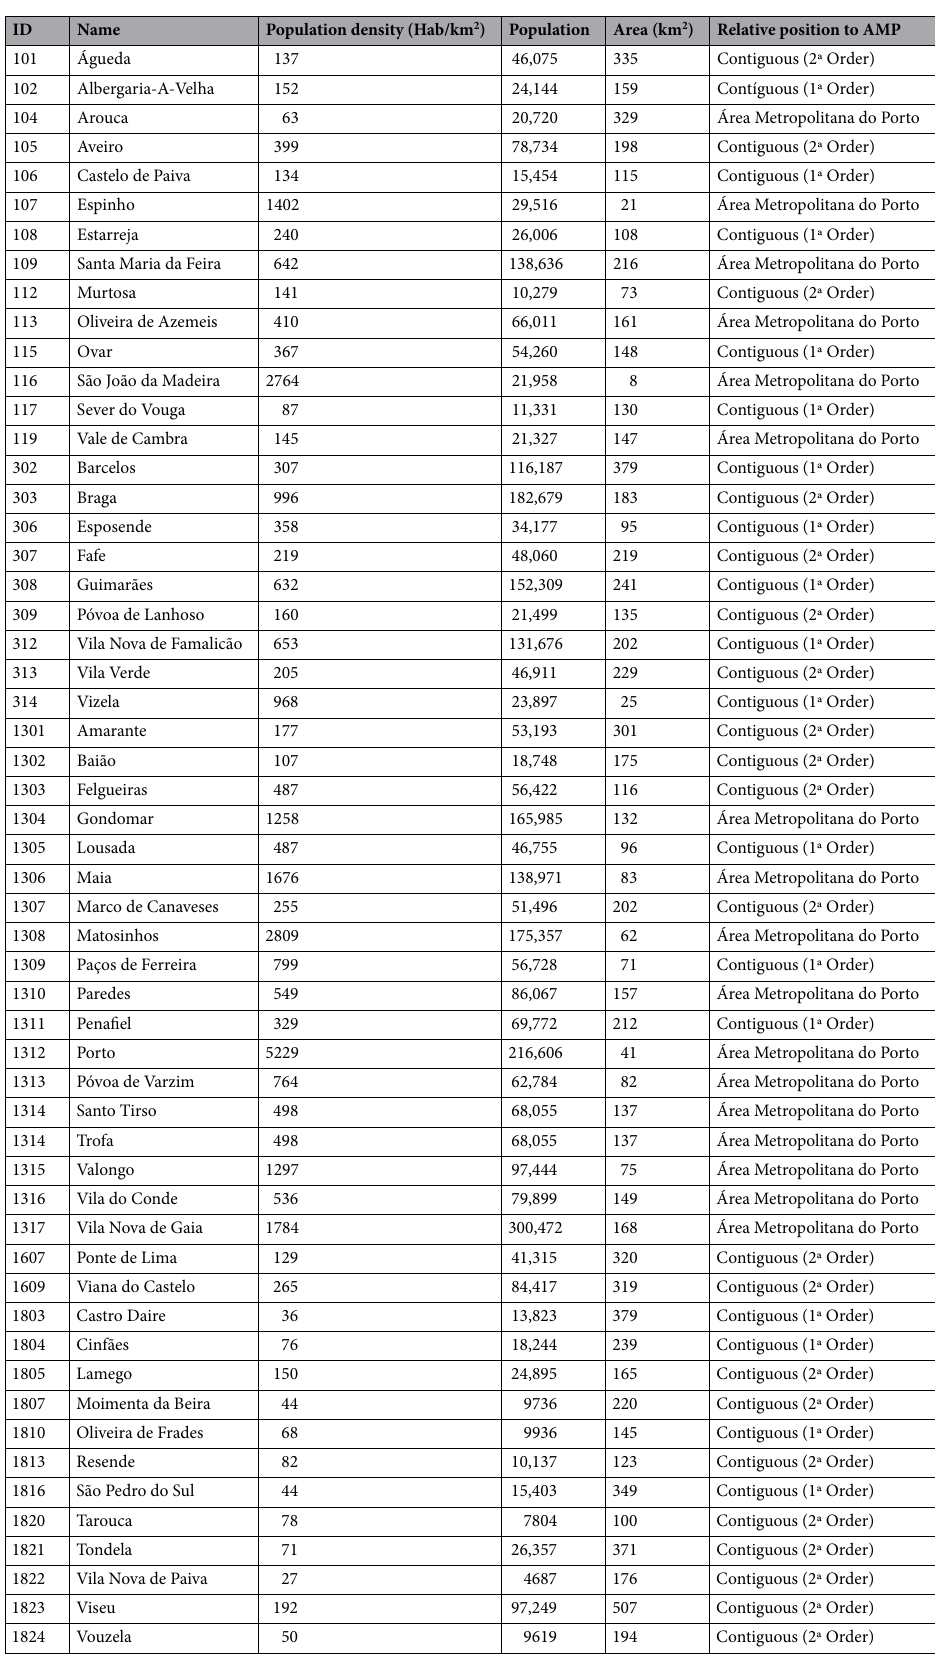
Table 1. List of municipalities within the research